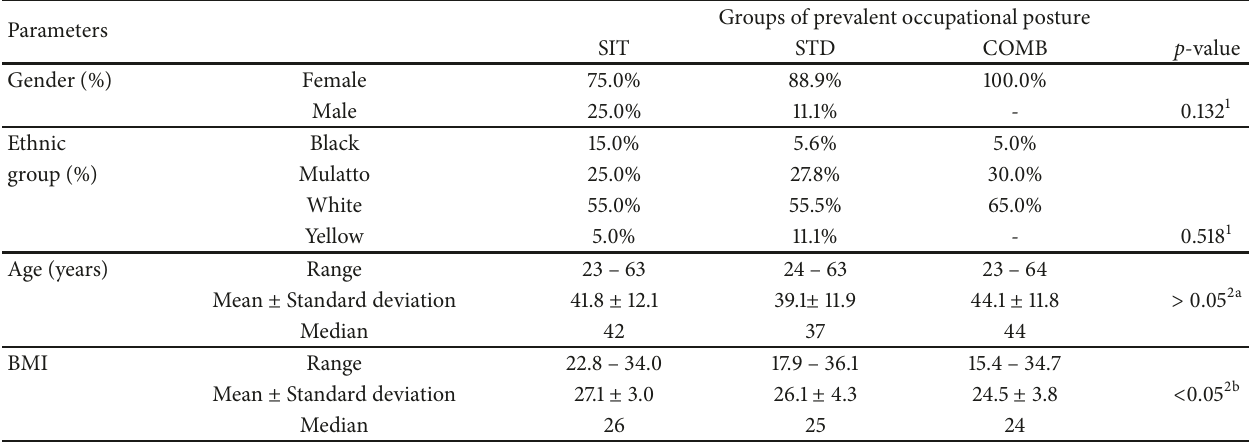
Table 1: Characterization of 60 professionally active individuals according to their prevalent occupational postures along a working day.